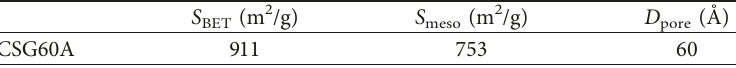
Table 1: Textural properties of MCSG60A.